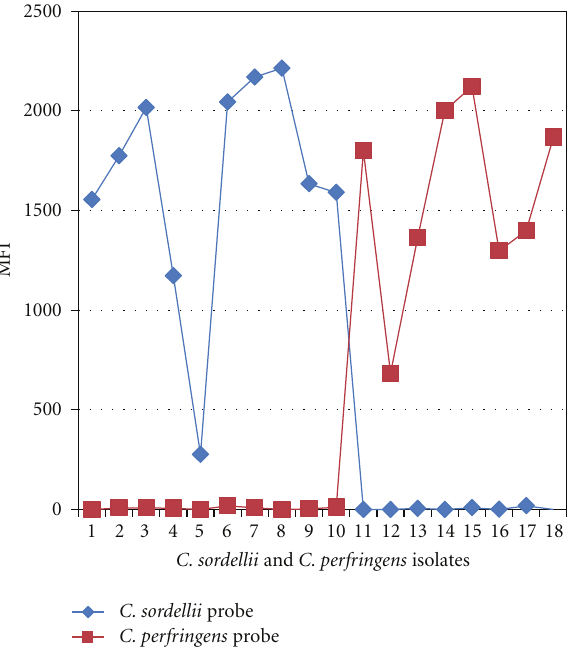
Figure 2: Identification of C. sordellii and C. perfringens in confirmed CTS cases by the microsphere assay. Cases 1–10: C. sordellii cases confirmed by conventional PCR and sequencing. Cases 11–18: C. perfringens cases confirmed by conventional